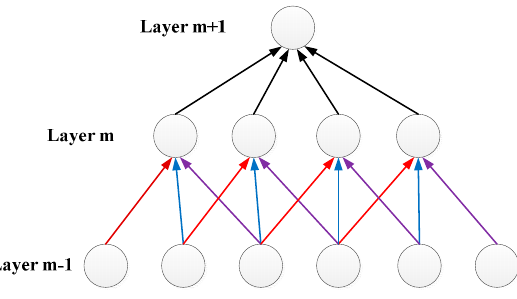
Figure 5. Sparse connection and shared weights in CNN.